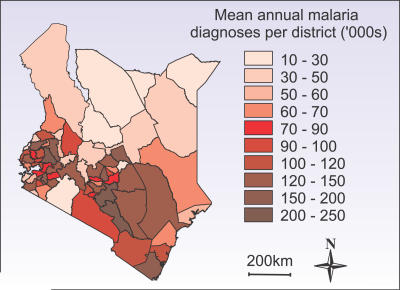
Number of Outpatients Treated for Malaria at Government FacilitiesPredicted mean annual totals for each district for the period 1996–2002. Values represent the combined sum of existing and predicted values.